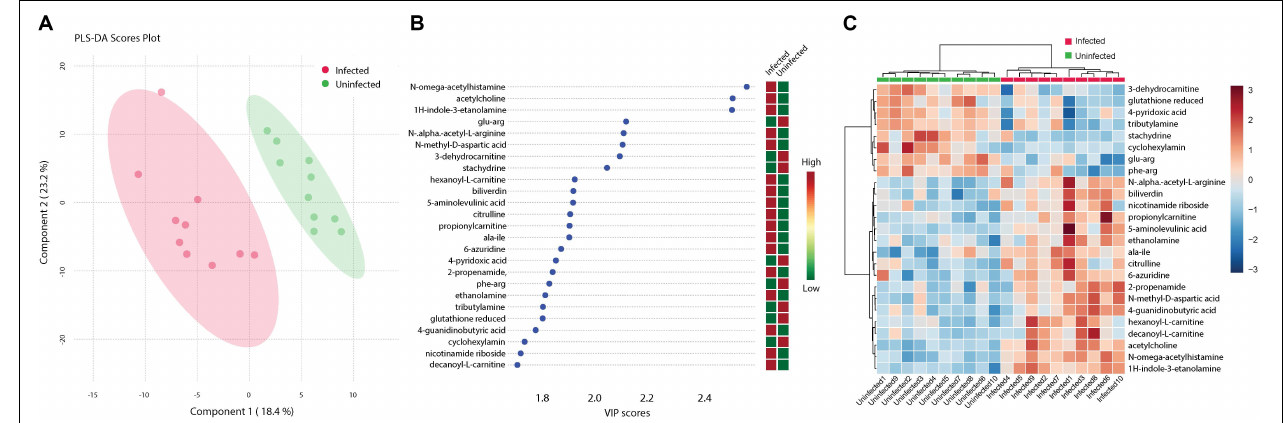
FIGURE 6 | Cluster analysis of biogenic amine levels differentiation due to ZIKV infection. Biogenic amines are low molecular weight organic compounds formed by decarboxylation of amino acids. (A) Clustering of biogenic amines using partial least squares’ discriminant analysis (PLS-DA) score plot after ZIKV infection of Ae. albopictus metabolites reveal a distinct intensity profile that can distinguish the ZIKV- infected from the uninfected Ae. albopictus individuals. (B) The color spectrum indicates the level of each compound Red indicates high intensity while green, low intensity. The VIP score indicates the level of importance of the biogenic amine to variance between treatment groups. (C) A heatmap was used to cluster the biogenic amines across the different infection status. Heatmap aesthetics are equivalent to those in Figures 1C , 4C